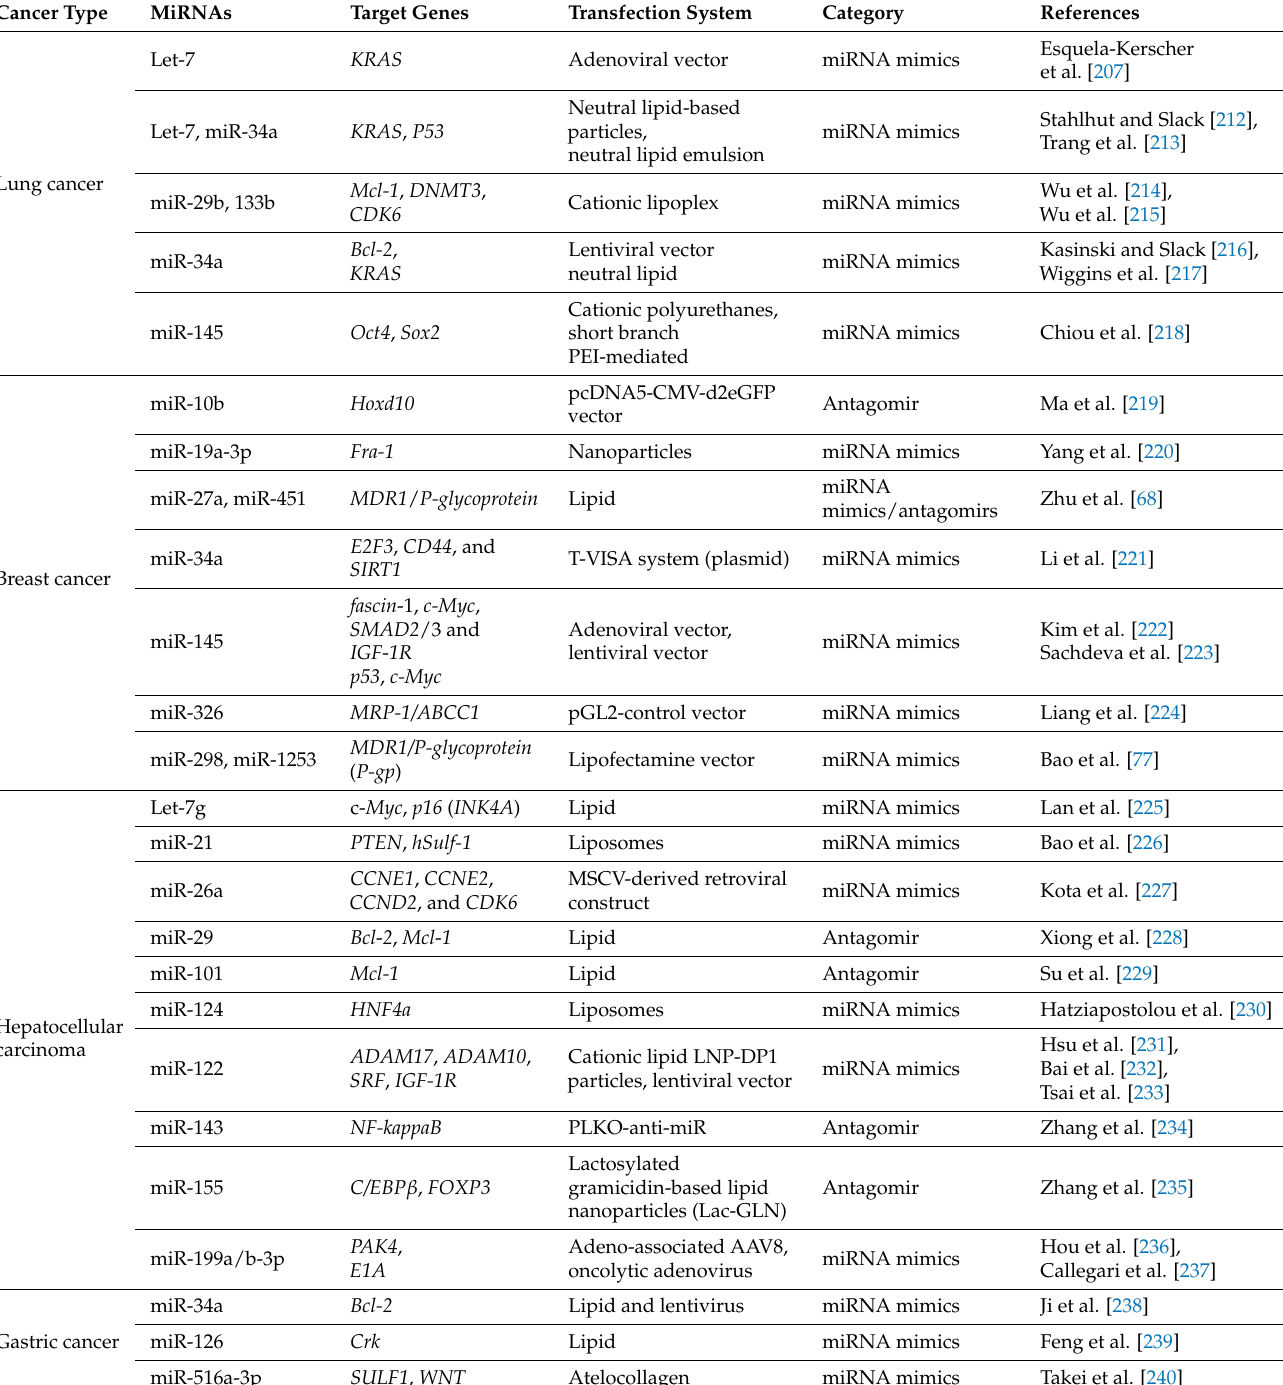
Table 3. List of microRNAs with therapeutic potential in human